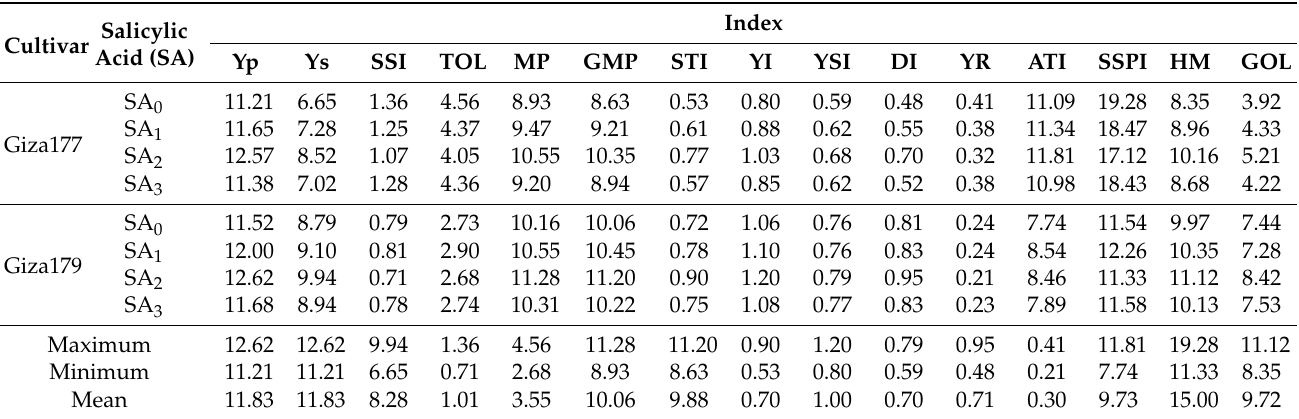
Table 7. Comparison of drought indices for two rice cultivars fertilized with different salicylic acid rates based on grain yield under normal and drought conditions (averaged over two years).